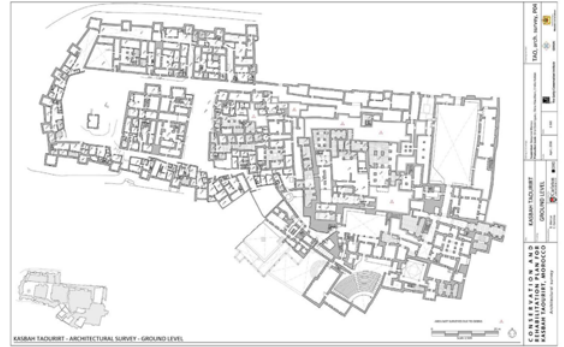
Figure 8: line drawing used for the rehabilitation plan of the Kasbah of Taourirt, result of the recording work, The Getty Conservation Institute and Carleton Immersive Media Studio.